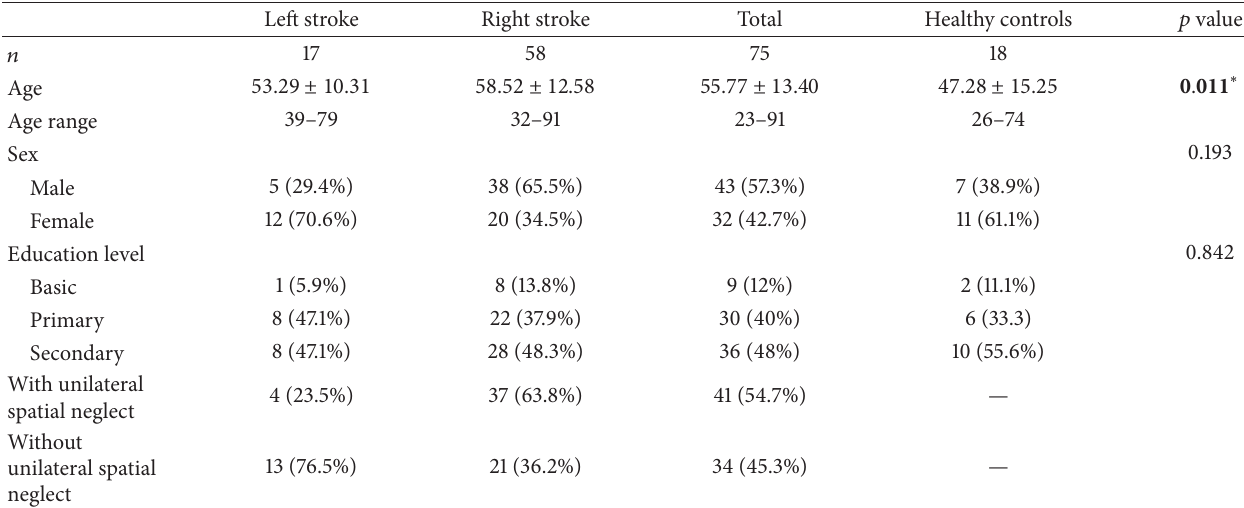
Table 1: Sociodemographic data. Complete sample.